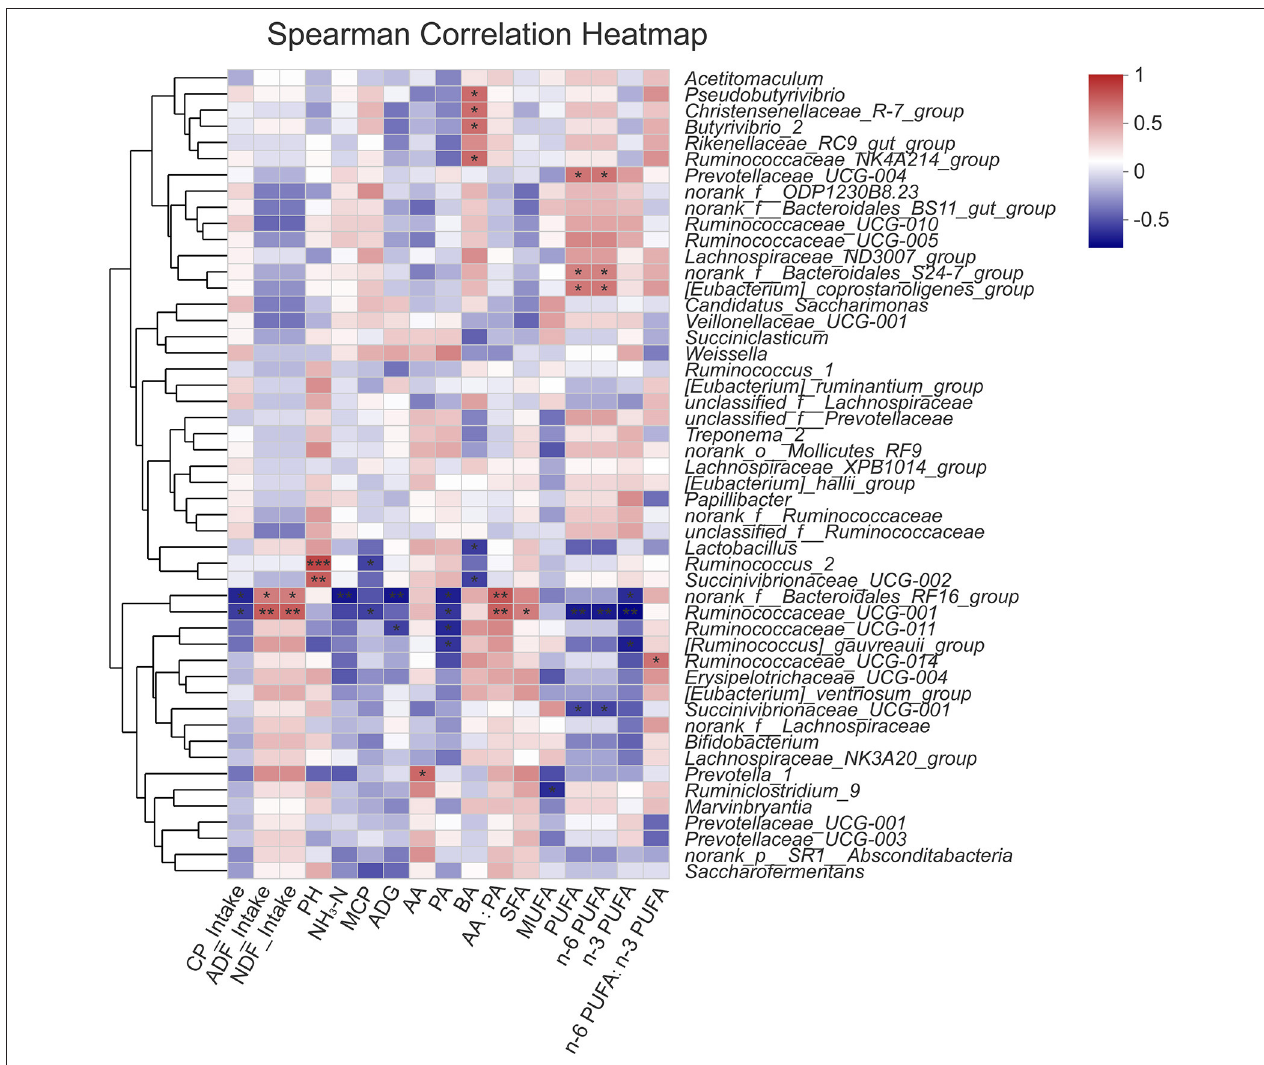
FIGURE 5 | Correlation between rumen microorganism and environmental factors. Red stands for positive correlation, blue stands for negative correlation. SFA, saturated fatty acids (14:0 + 16:0 + 18:0 + 20:0); MUFA, monounsaturated fatty acids (16:1 + 17:1 + 9c18:1 + 20:1); PUFA, polyunsaturated fatty acids (18:2 n − 6 + 18:3 n − 3 + 20:4 n − 6); n − 6 PUFA (18:2 n − 6 + 20:4 n − 6); n − 3 PUFA (18:3 n − 3). * P < 0.05, ** P < 0.01, *** P <